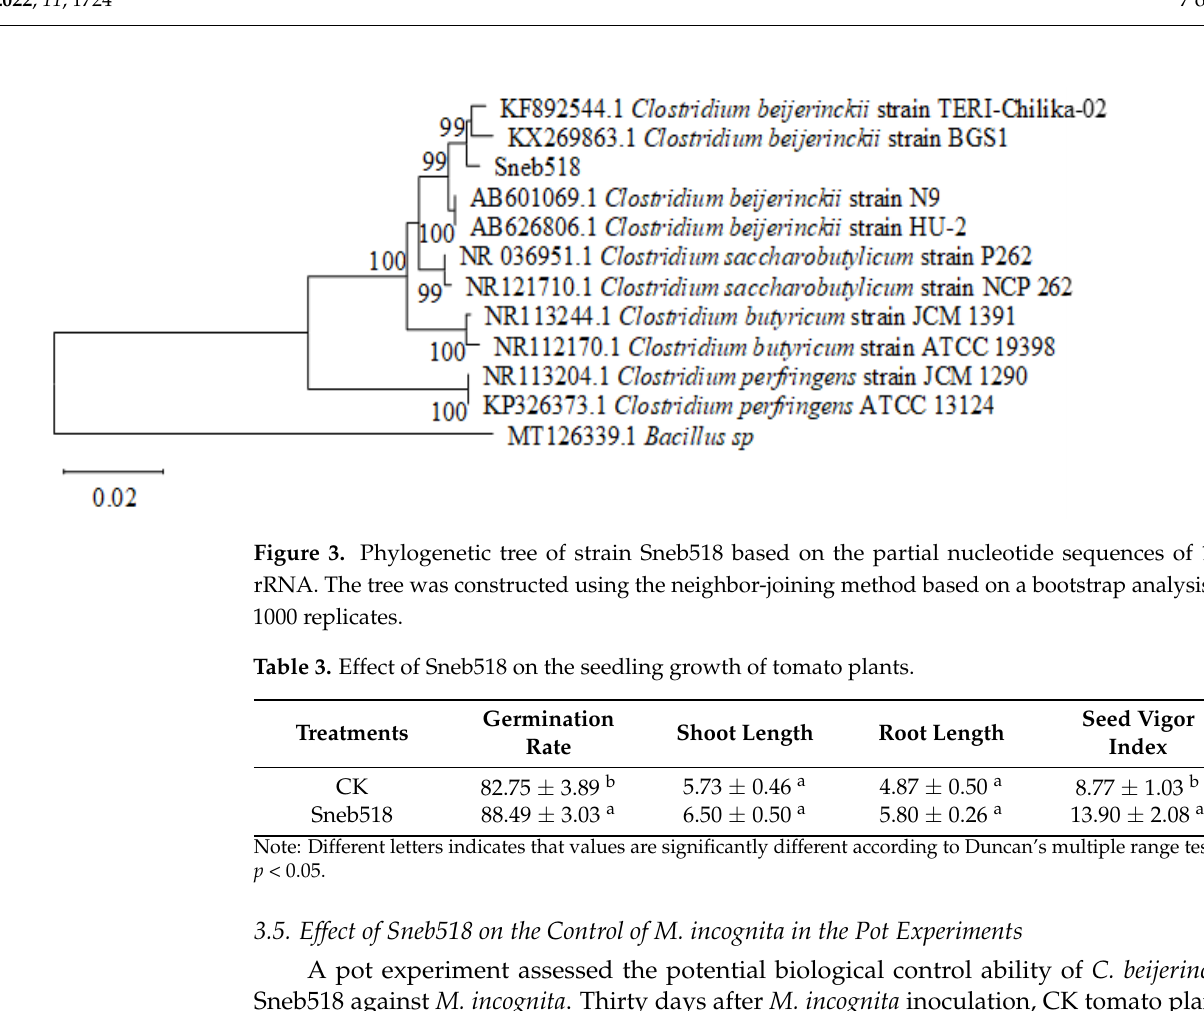
Table 3. Effect of Sneb518 on the seedling growth of tomato plants.